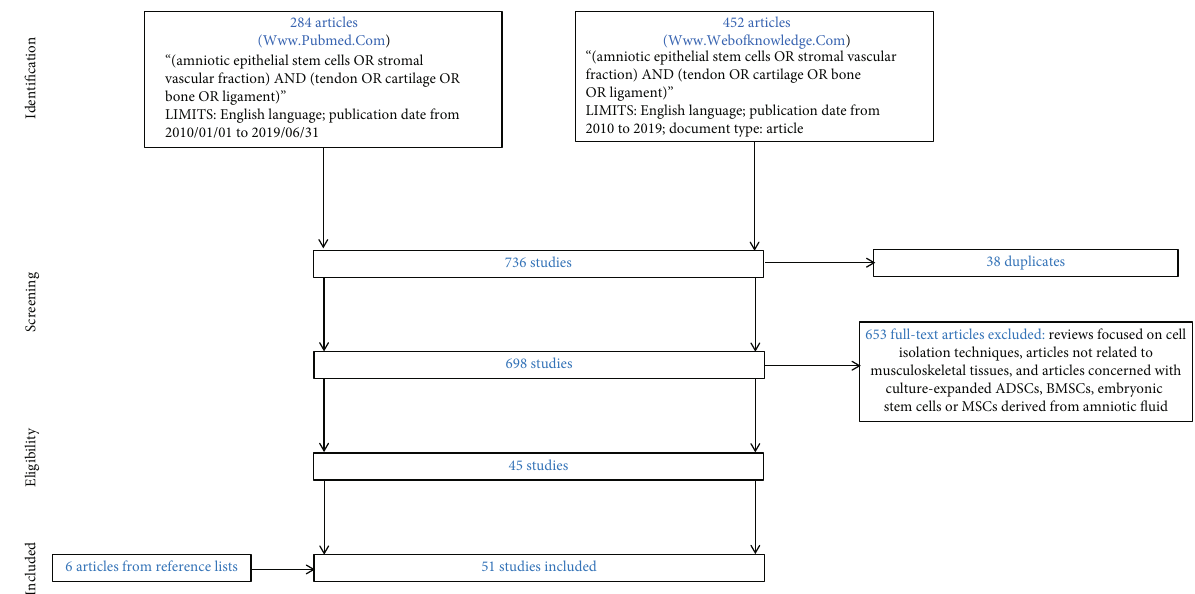
Figure 1: Schematic representation of the search